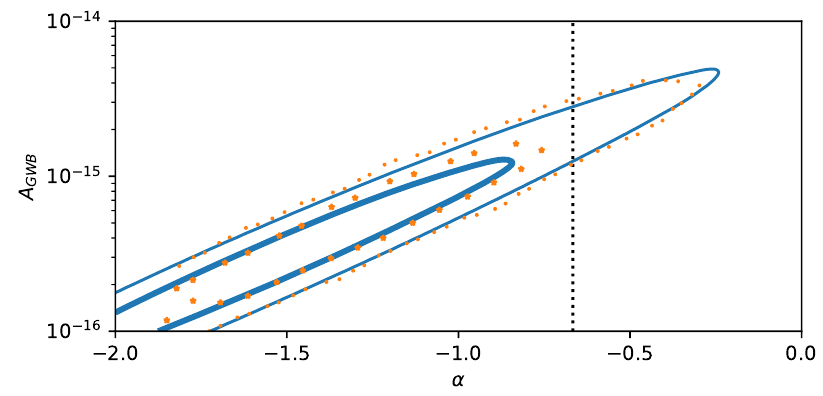
Figure 1: Comparison of 1 σ and 2 σ contours for a single power law fit to the 5 lowest frequency bins. Our results are shown with continuous blue lines and the original result with orange dots. The black dotted line sits at α = − 2 / 3, the expected slope for the signal of